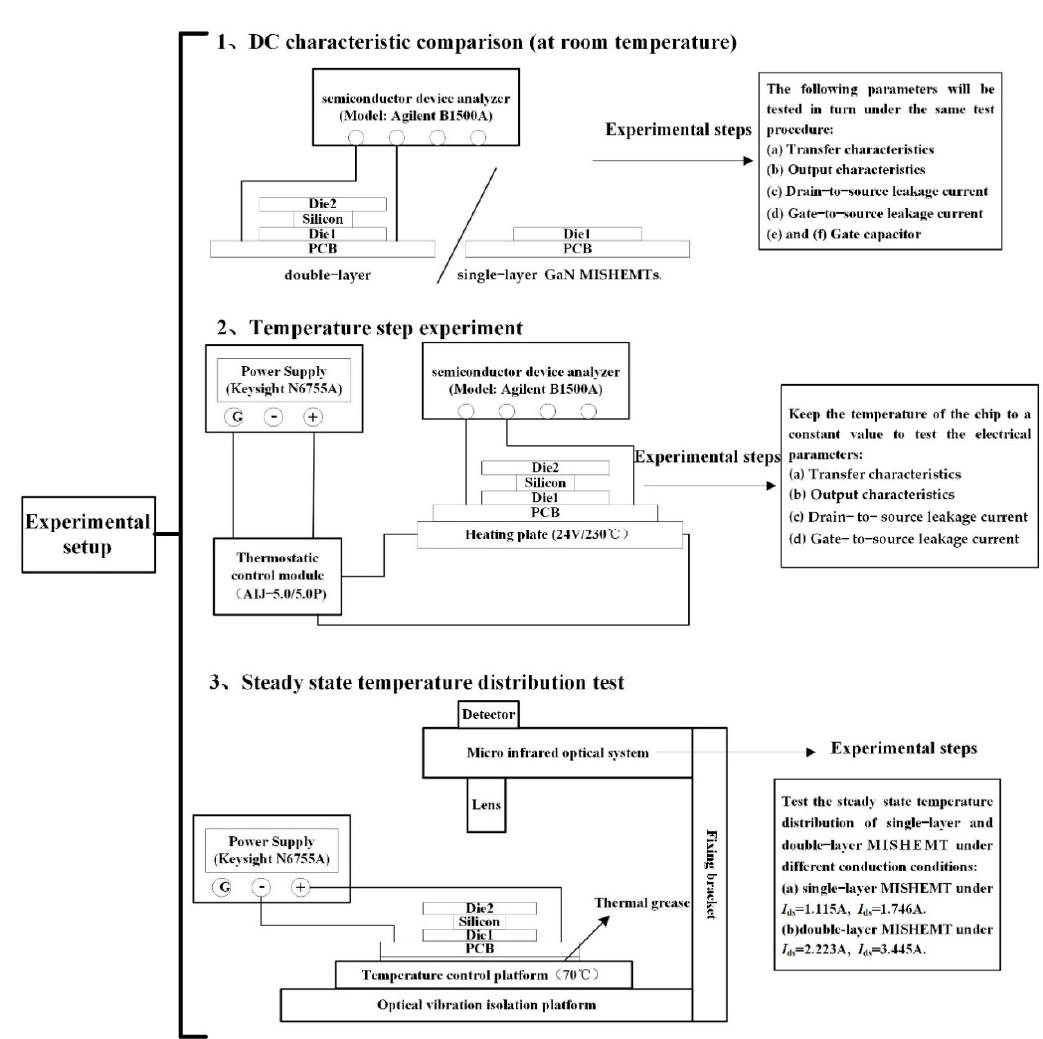
Figure 3. Experimental setup diagram.